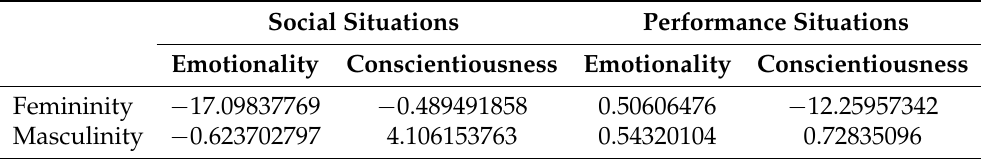
Table 11. Core G with the TuckerALS algorithm for behavioral level data.